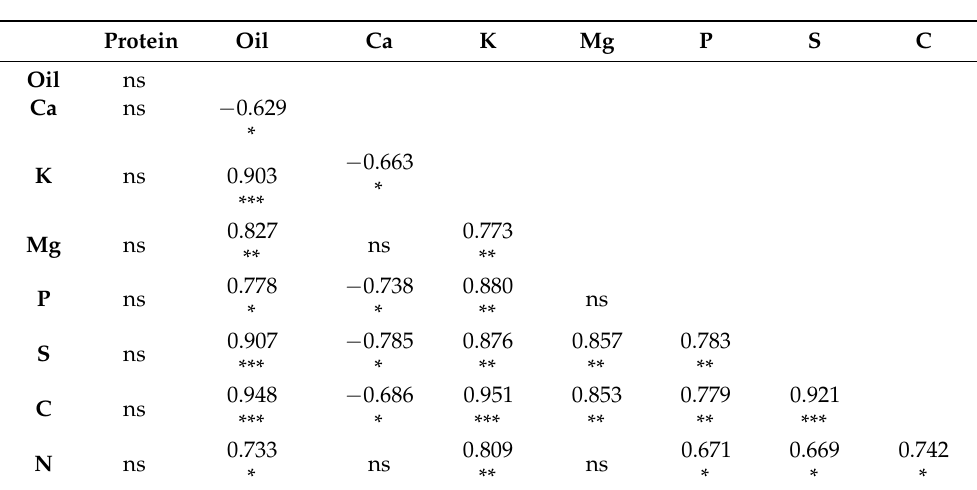
Table 4. Pearson correlation coefficients (P and R values) between seed nutrients in the near-isogenic lines (Uzbek curly leaf, DP 5690 wild type, and DP 5690 curly leaf) cotton in 2014. The experiment was conducted in Stoneville, MS,